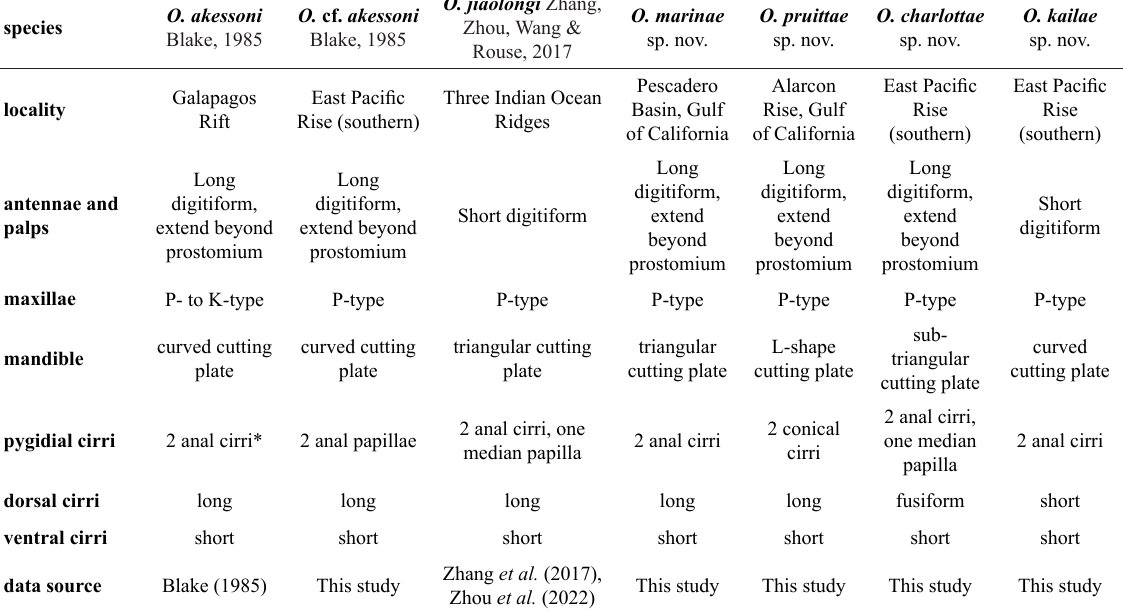
Table 3. Comparative list of selected characters for the vent-endemic radiation of Ophryotrocha Claparède & Mecznikow, 1869 in clade B. * = No further details or drawing are provided in Blake